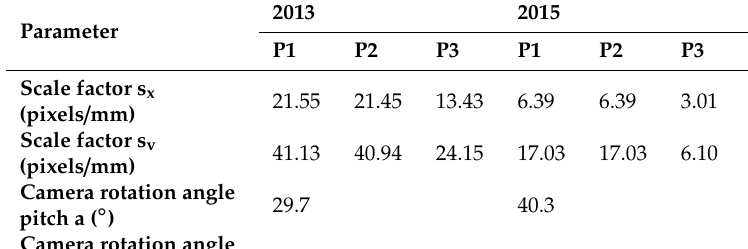
Table 1. Data used for the image coordinate transformation.